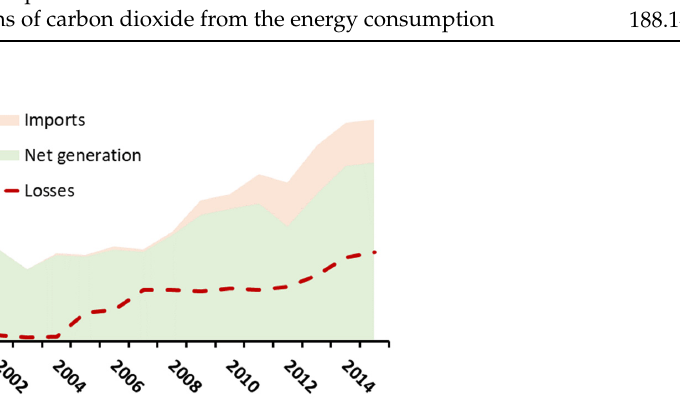
Figure 4. Net electricity generation, imports, and distribution losses in Iraq (data extracted from [35]).